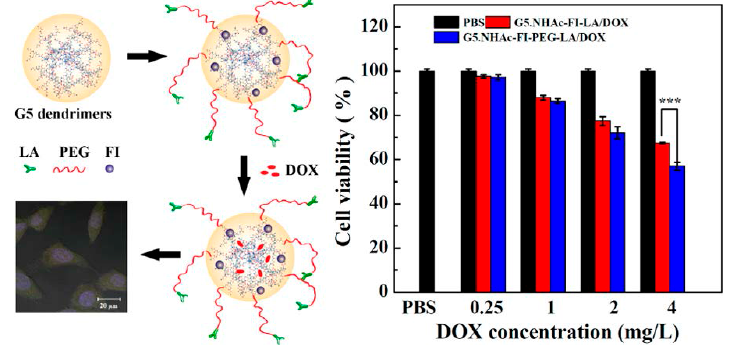
Figure 8. Multifunctional lactobionic acid-modified dendrimers for targeted drug delivery to liver cancer cells [223].